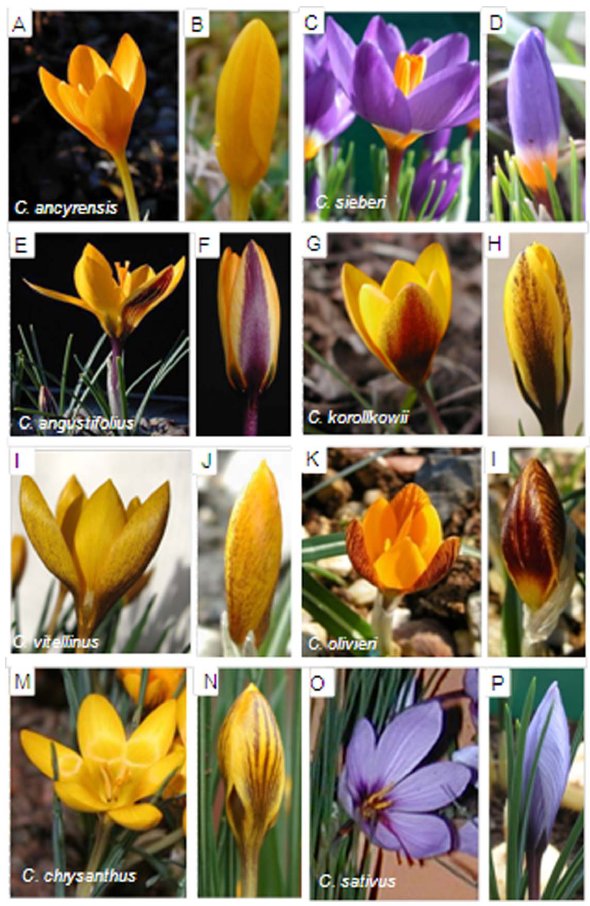
Figure 1. Open and closed flowers of Crocus species with yellow colours in tepals. Flowers of Crocus ancyrensis (A and B), C sieberi (C and D), C. angustifolius (E and F), C. korollkowii (G and H), C. vitellinus (I and J) and C. olivieri (K and L). Flower of C. sativus (M and N) used as reference.